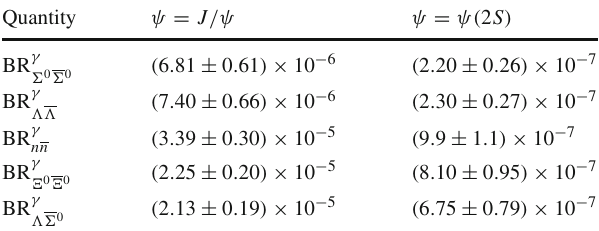
Table 5 Electromagnetic BRs computed through Eq. (11) and using the values of | D e | given in Eq. (19) (second and fourth equations)